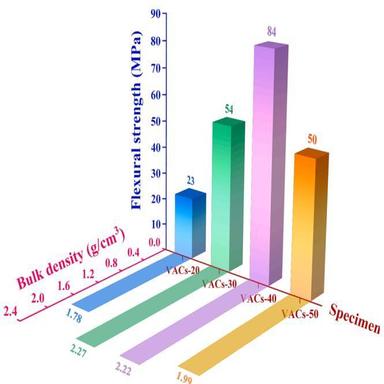
Bulk density and flexural strength of sintered VACs specimens.